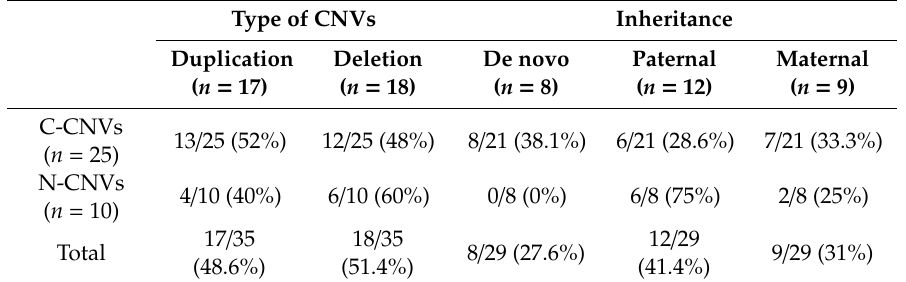
Table 3. Proportion of deletions vs. duplications and pattern of inheritance of the reported CNVs according to their classification (causative vs.